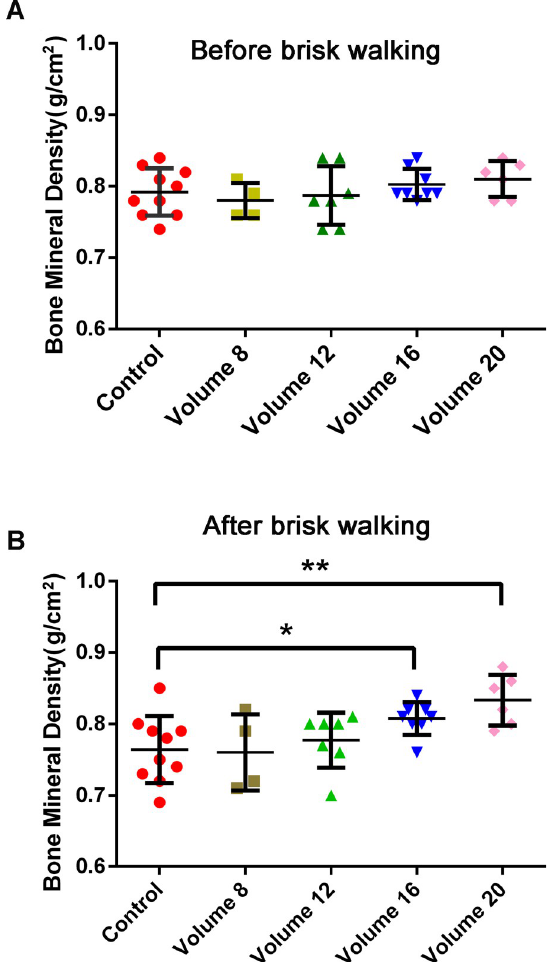
Fig 2. Comparison of BMD between the control group, the volume 8 group, the volume 12 group, the volume 16 group and the volume 20 group before and after brisk walking. (A) There were no significant differences between the control group, the volume 8 group, the volume 12 group, the volume 16 group and the volume 20 group before brisk walking. Volume = frequency x duration, which was calculated according to the self-reported Physical Activity Index questionnaire. The subjects whose volume was � 8 were assigned to the volume 8 group and so forth. (B) Compared with the control group, significant differences were observed in the volume 16 group and the volume 20 group. � P < 0.05; �� P <